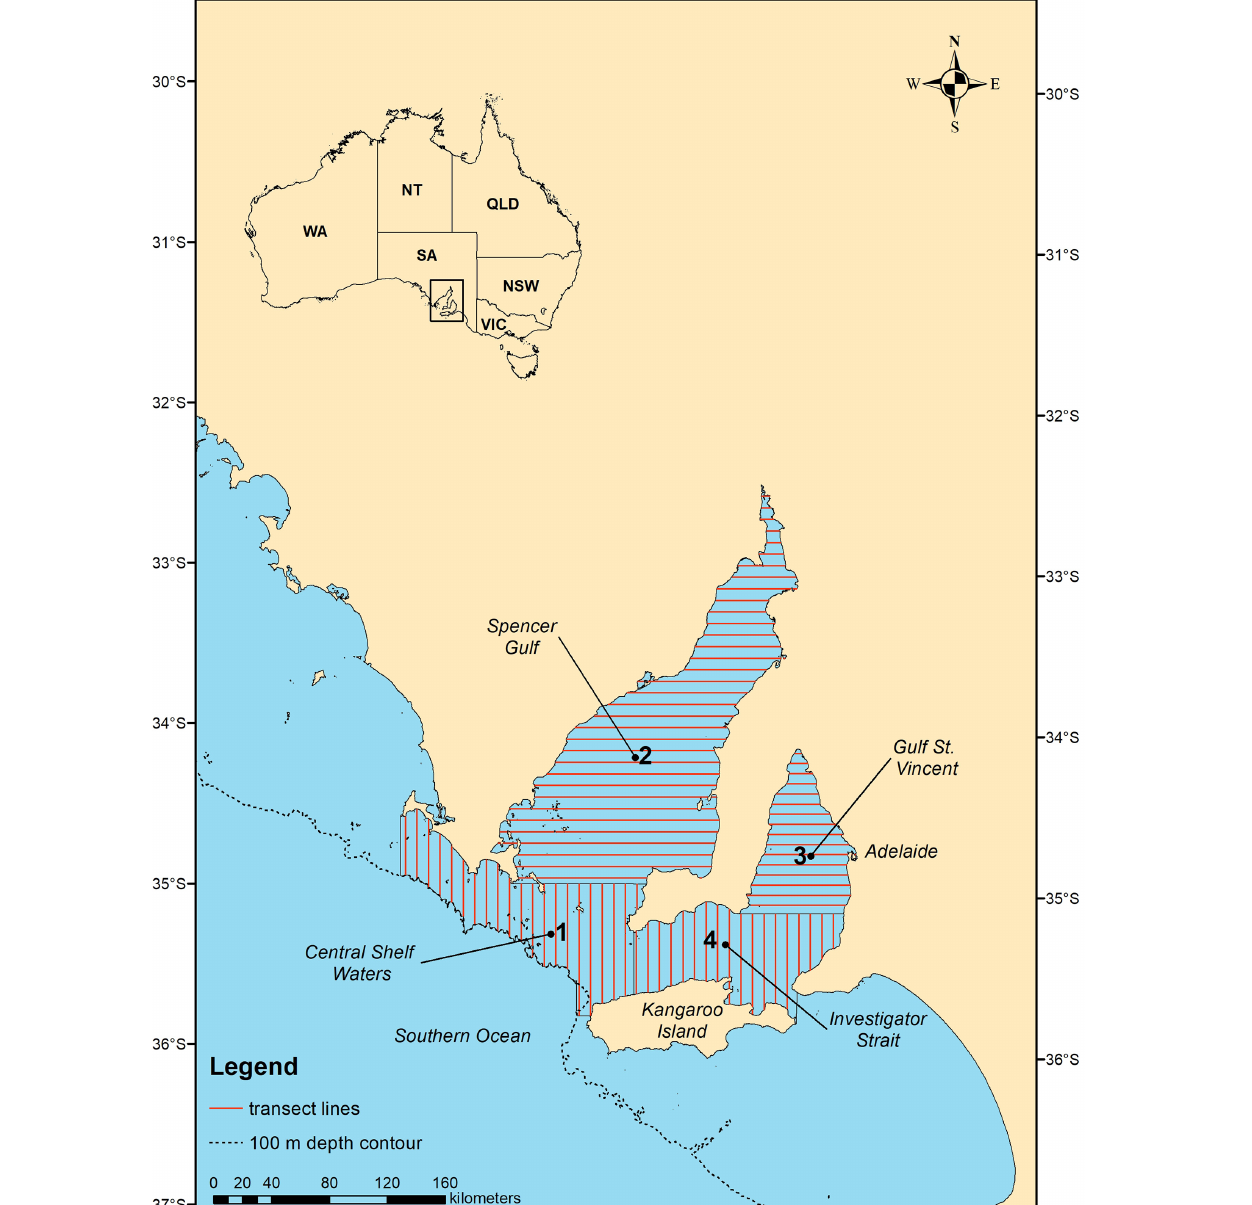
digital photographs to confirm species identification and school size. A school was defined as individuals that were within a 100 m radius of each other and traveling in the same direction or exhibiting the same behavioral state. Survey effort then resumed at the same location where line transect effort was suspended. Transects were flown once in summer/autumn, and once in